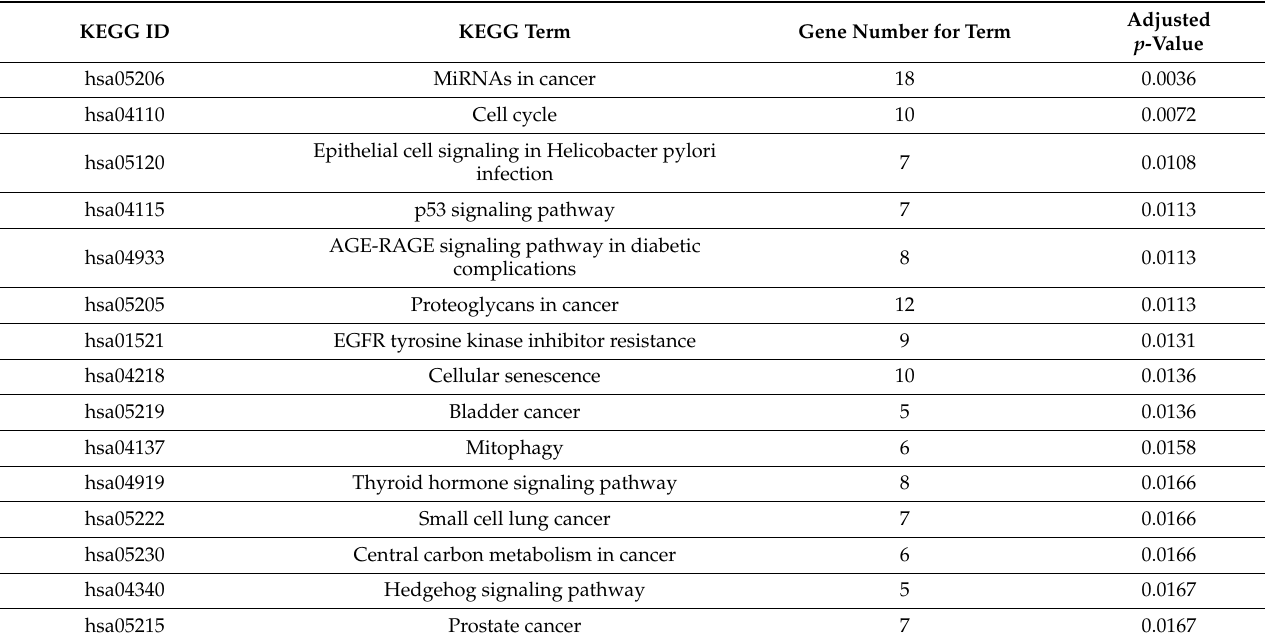
Table 4. The top 15 enriched KEGG pathways across predicted targets of miRNAs with different levels in plasma and